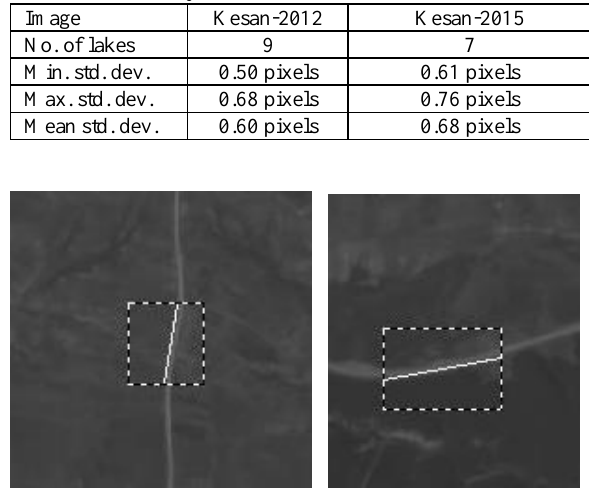
Figure 5. Examples to the along-track (left) and across-track (right) road lines used for the MTF analysis. Table 5. MTF50 results of both panchromatic images.